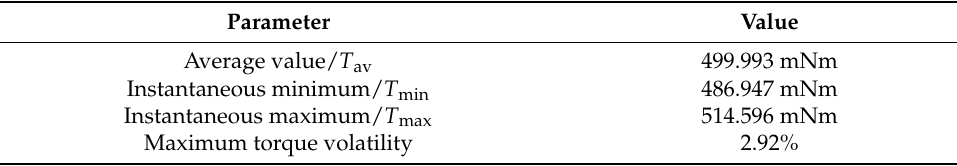
Figure 15. Optimized output torque. Table 4. Output Torque Parameters of Optimized AFPMBLDCM.